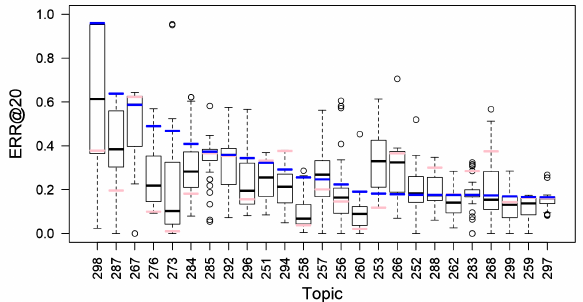
Figure 8. In the easiest topics according to the median effectiveness on the participants’ results, there are both topics with very diverse system effectiveness results (e.g., 298) and very similar ones (e.g., topic 285)—Web track 2014—topics are ordered according to decreasing the err@20 of the best system. Figure reprinted with permission from [44], Copyright 2014, Kevyn Collins-Thompson et al.